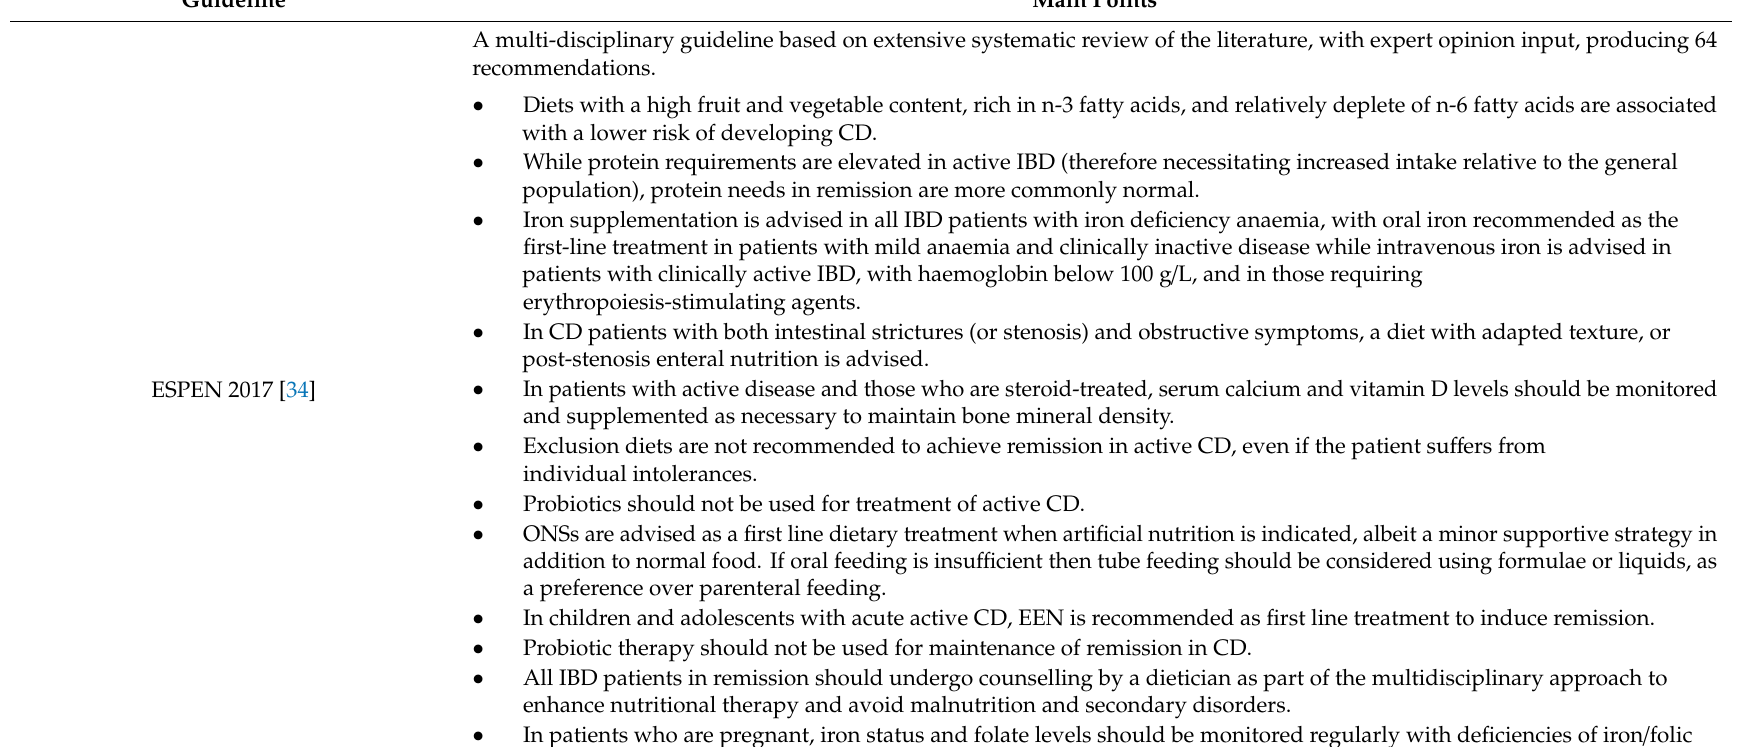
Table 2. Guidelines currently in use for enteral nutrition in Crohn’s disease. The main points are described.